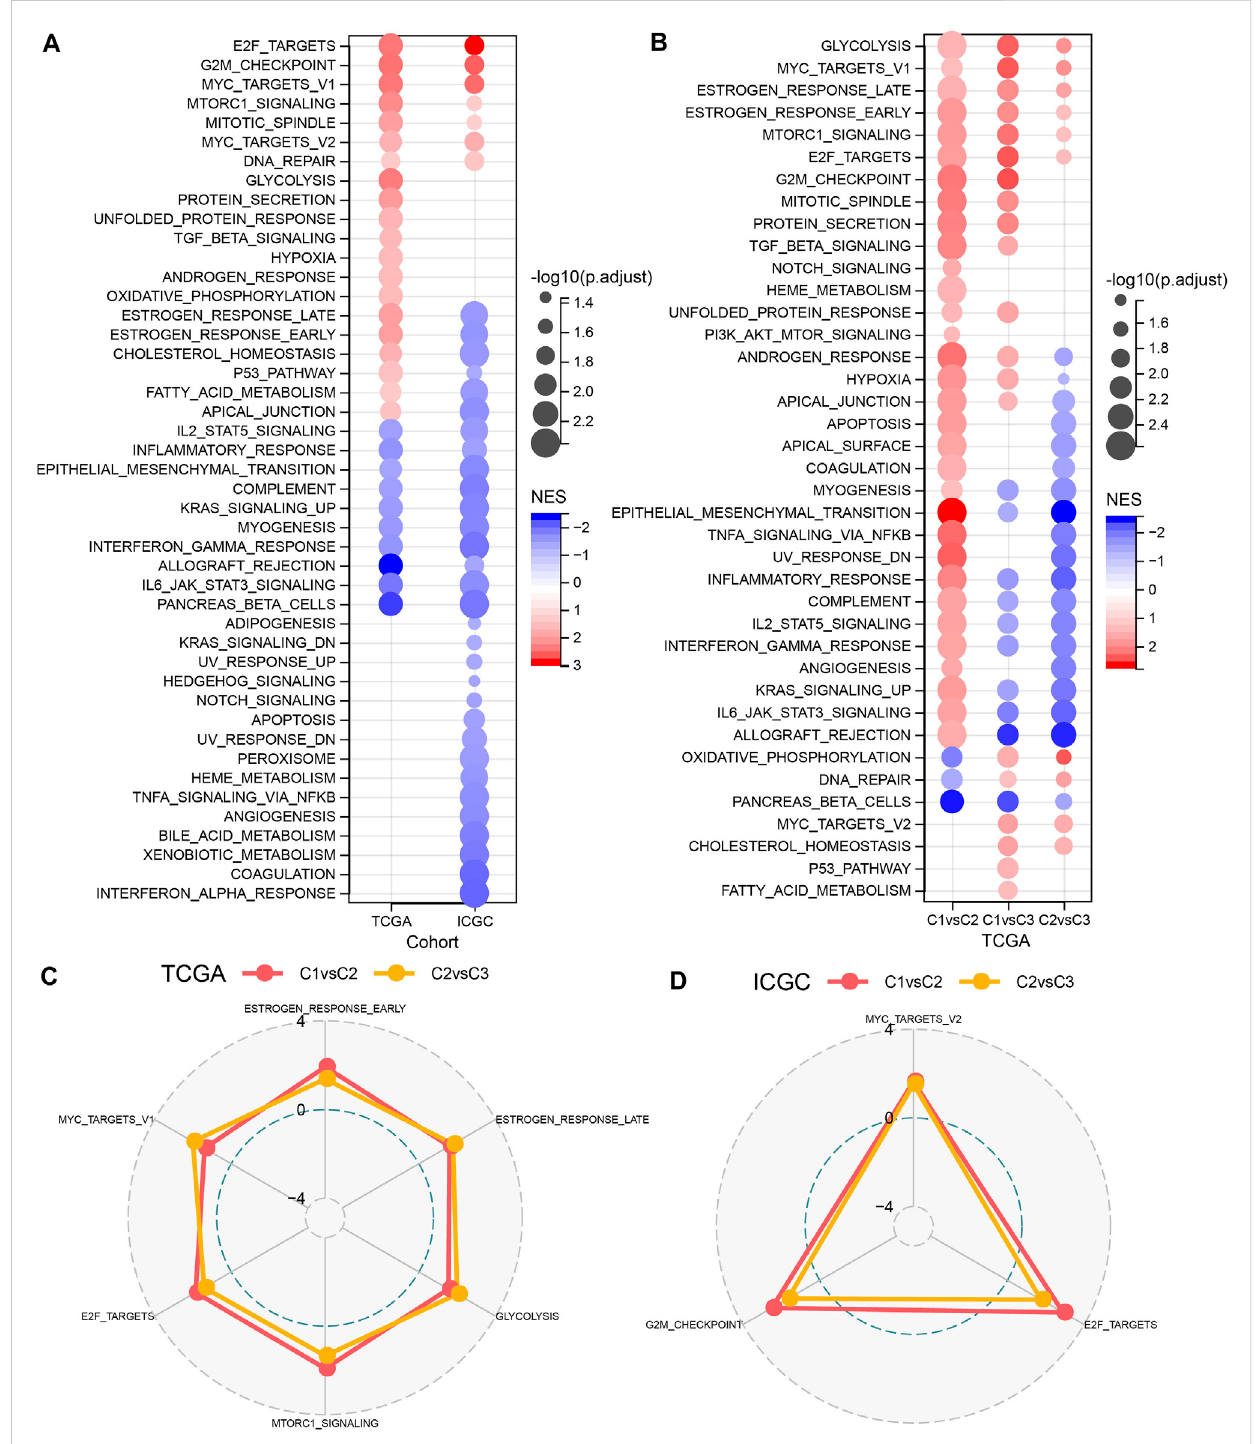
FIGURE 3 The comparison of pathways between molecular subtypes. (A) Bubble chart of GSEA analysis results of the TCGA cohort and the ICGC cohort. (B) Bubble chart of the GSEA analysis results of C1 vs. C3, C1 vs. C2, and C2 vs. C3 in the TCGA cohorts; (C) The radar chart of the C1vsC2, C2vsC3 coherent activation pathway in the TCGA cohort; (D) The radar plot of the C1vsC2, C2vsC3 coherent activation pathway in the ICGC